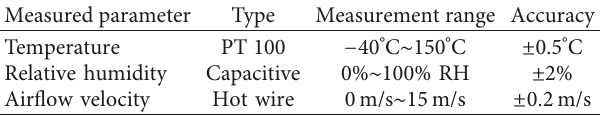
Figure 4: Photograph of the experimental set up. Table 1: Measured parameters.